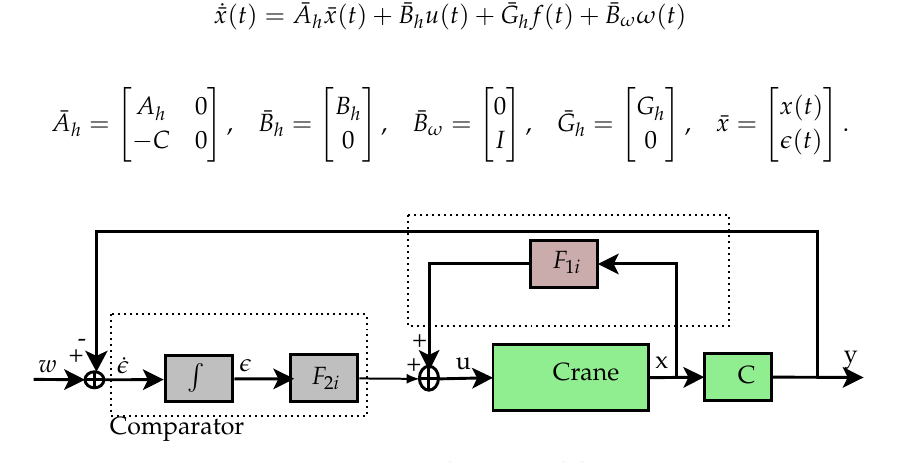
Figure 2. Convex tracking control